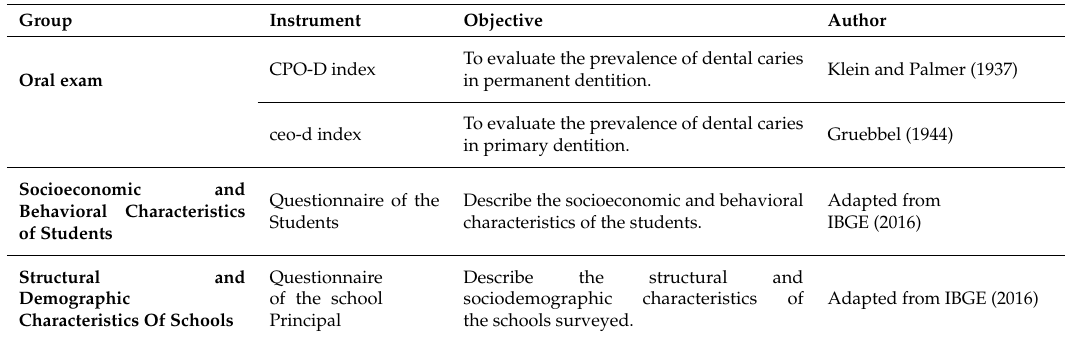
Table 5. Instruments used in the study development. Source: Chart adapted by the author himself from the National School Health Survey conducted in Brazil in 2015